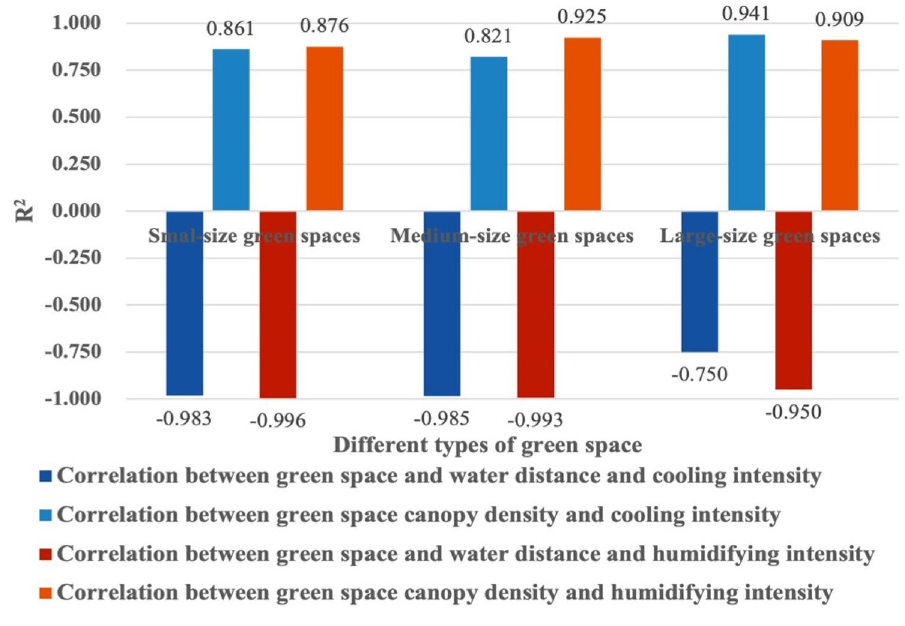
Figure 15. Correlation of different green space types with water distance, canopy density and cooling and humidifying